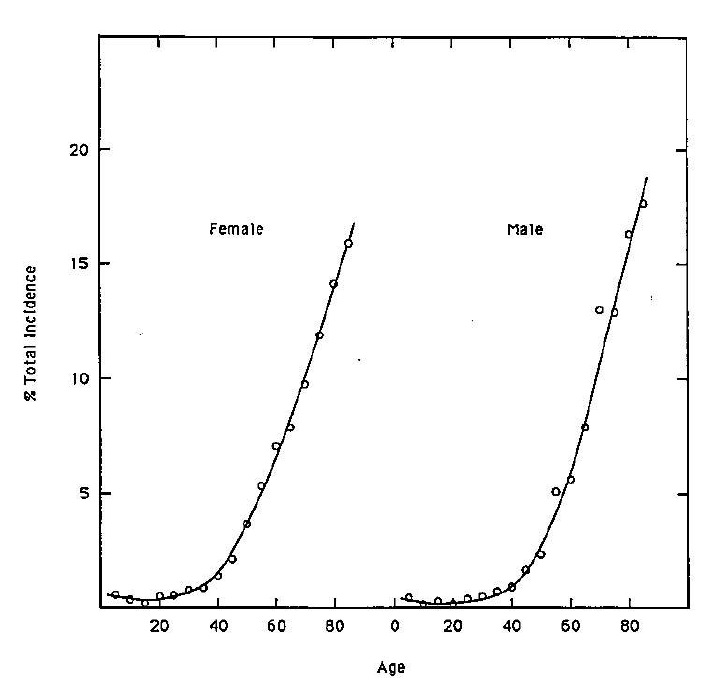
Figure 7 . Cancer incidence as a function